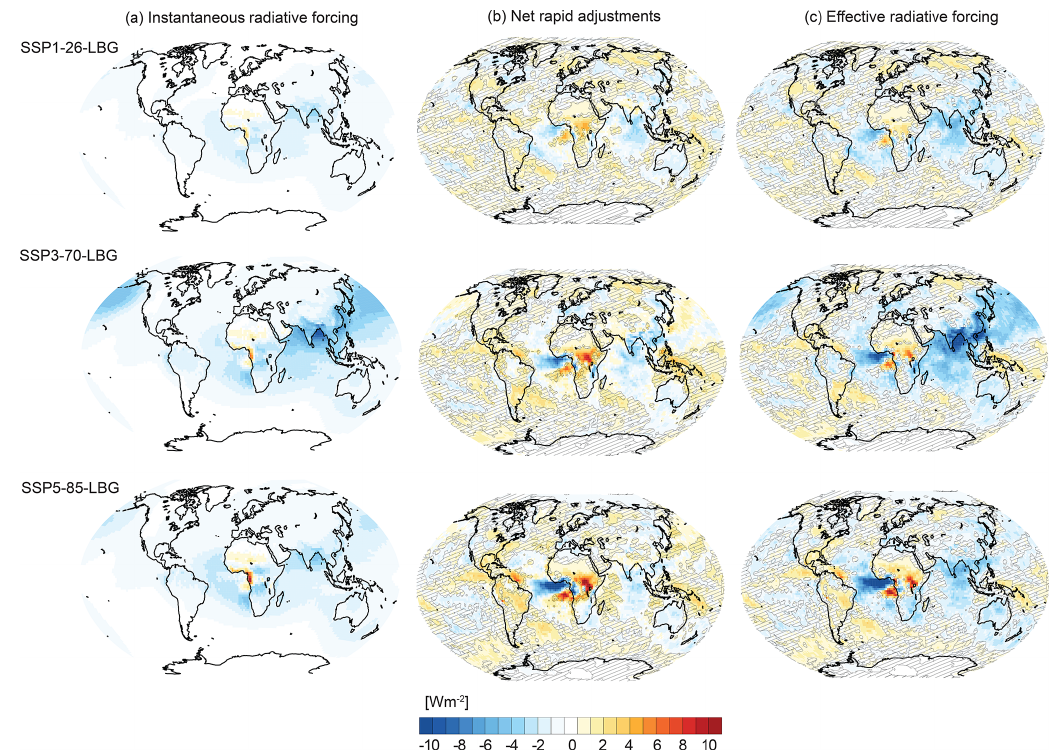
Figure 9. All-sky radiative forcing for the mid-2090s with strong Twomey effects. As Fig. 8, but with stronger Twomey effects due to increasing η N (Sect.